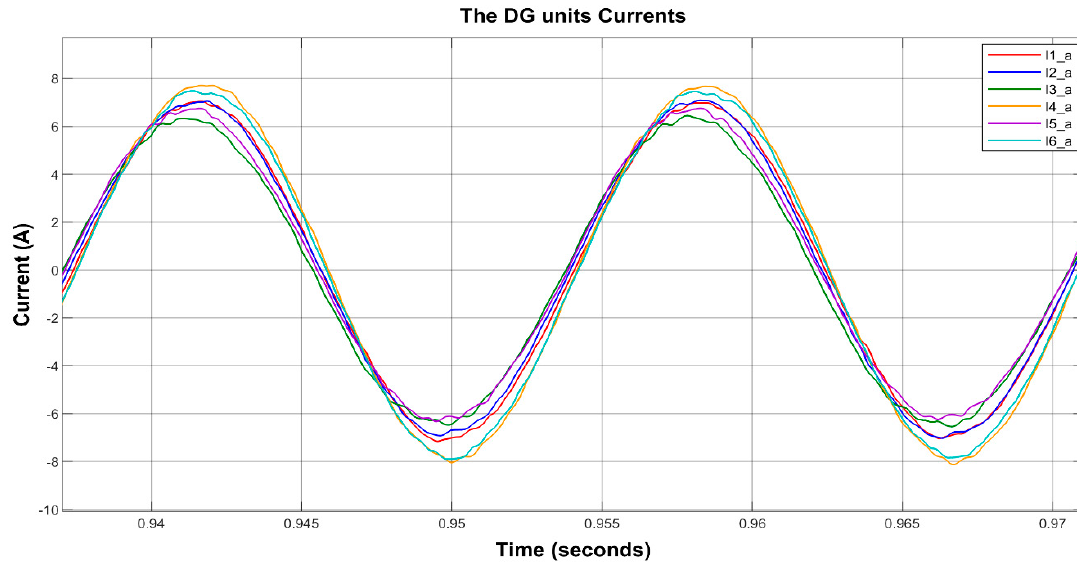
Figure 12. The DG units’ of phase a of output current for Case 1.